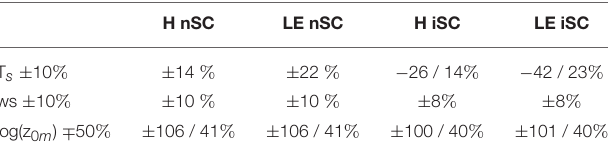
TABLE 3 | Sensitivity of both turbulent fluxes to changes in input variables surface temperature (T s ), wind speed (ws) and surface roughness (z 0 m ).